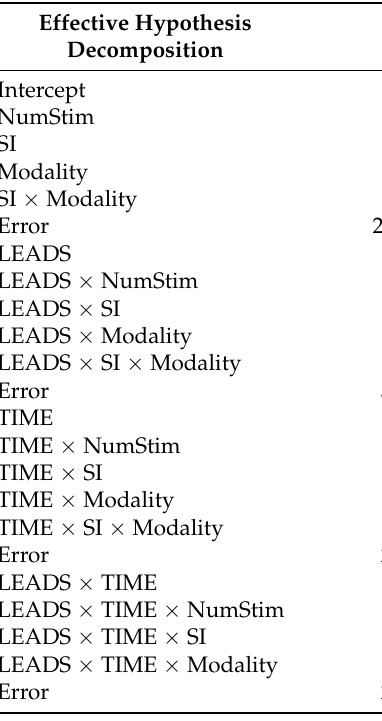
Table 2. Repeated Measures Analysis of Variance